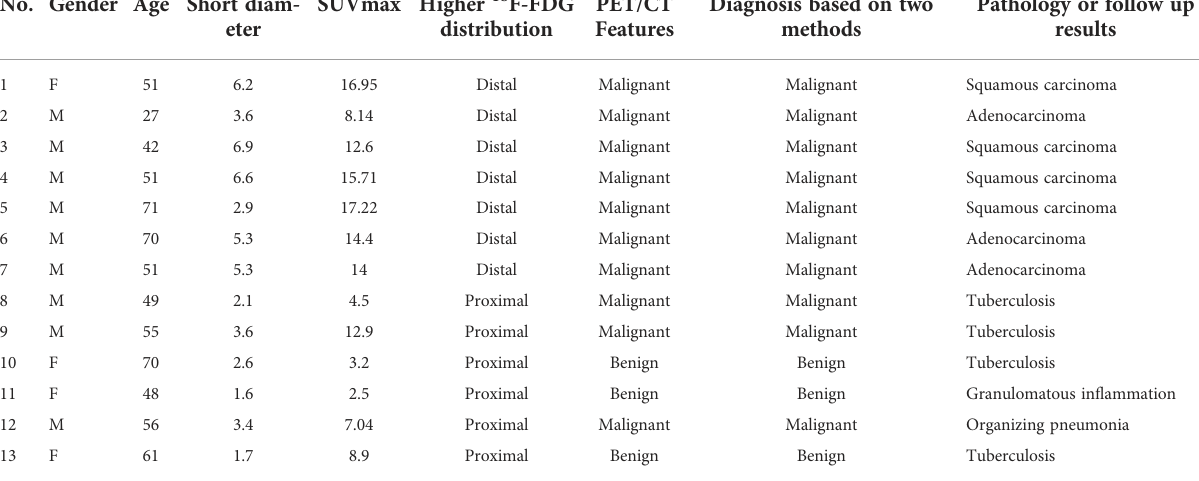
TABLE 4 Clinical characteristic and image features of 7 false negative lesions and 6 false positive lesions based on 18 F-FDG distribution pattern. No. Gender Age Short diam- eter